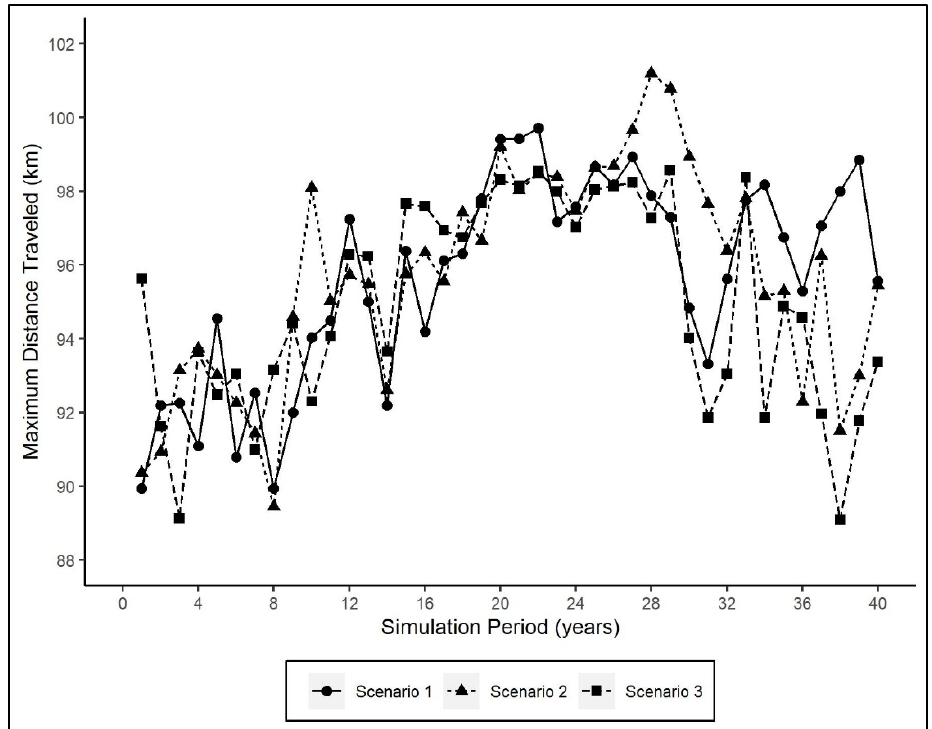
Figure 10. Distribution of maximum distance traveled over the simulation period. Scenarios 1, 2 and 3 are differentiated in Table 1.